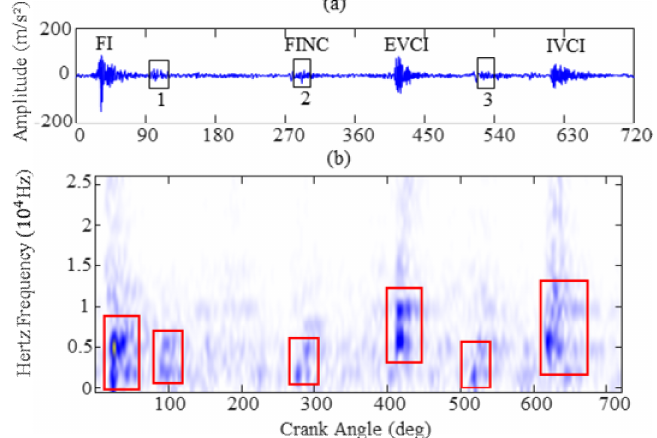
Figure 4. Vibration signal of NVC: ( a ) original signal waveform; ( b ) short time Fourier transform spectrum (STFT).